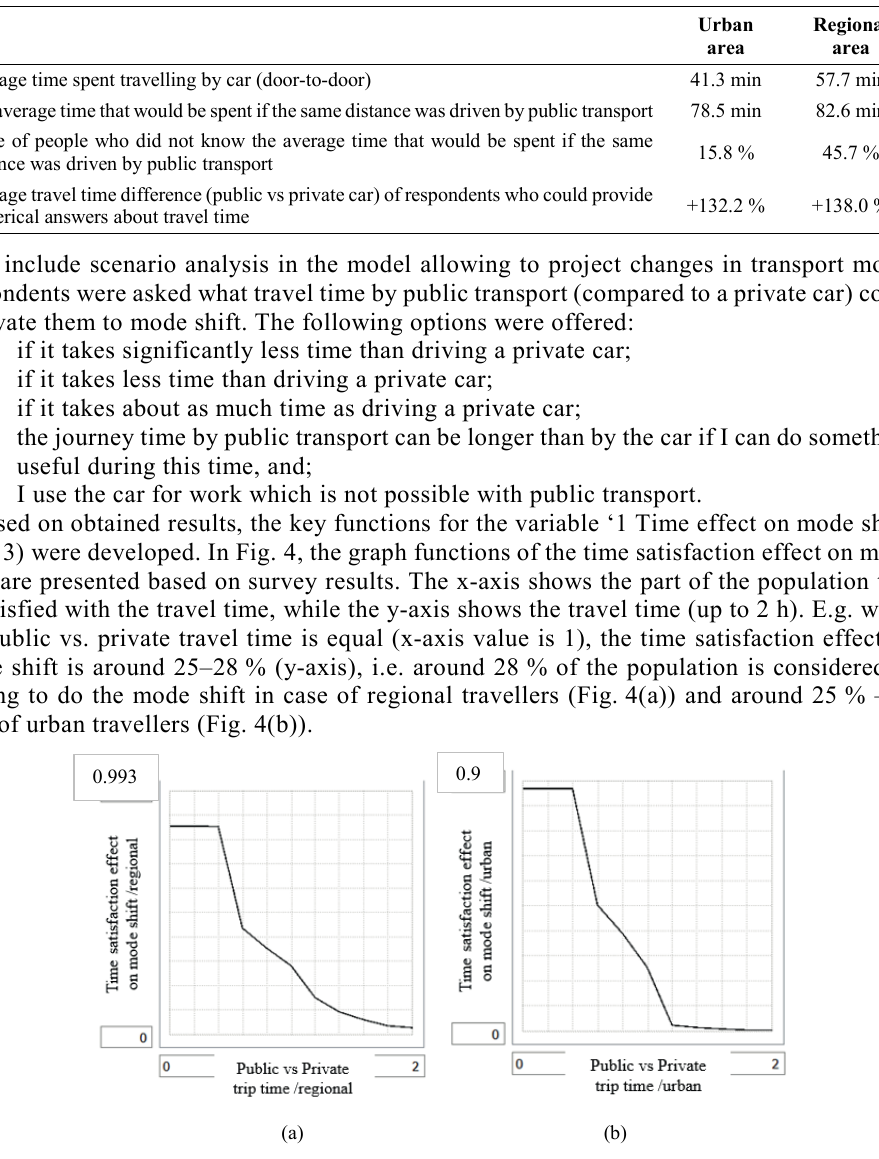
Fig. 4. Time satisfaction effect on mode shift (a - regional, b -